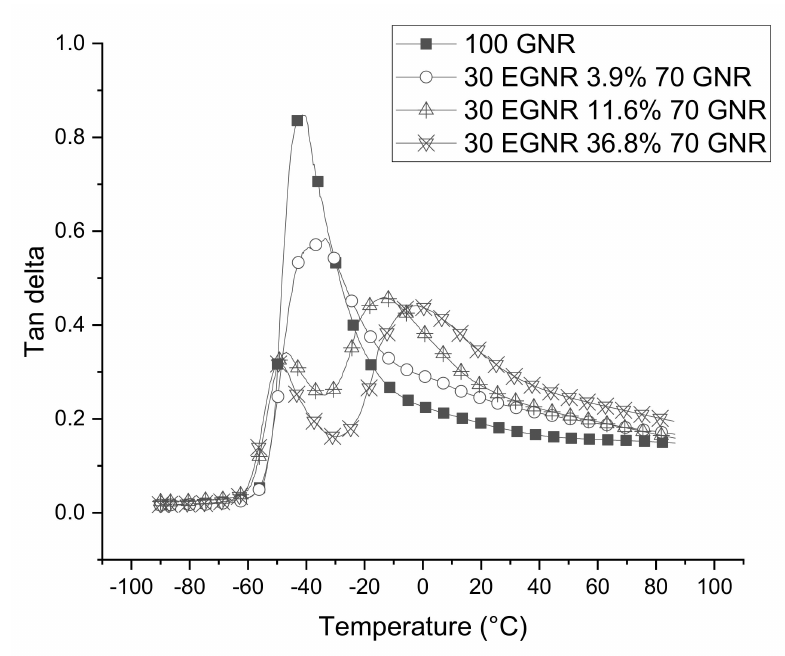
Figure 9. Tan δ of guayule natural rubber/epoxidized guayule natural rubber blend composites with various epoxide fractions. GNR 50CB: guayule natural rubber composites without epoxidation; 30EGNR 3.9% 70GNR 50CB: guayule natural rubber/epoxidized guayule natural rubber blend com- posites with 3.9% epoxide fraction; 30EGNR 11.6% 70GNR 50CB: guayule natural rubber/epoxidized guayule natural rubber blend composites with 11.6% epoxide fraction; 30EGNR 36.8% 70GNR 50CB: guayule natural rubber/epoxidized guayule natural rubber blend composites with 36.8% epoxide fraction. Table 6. Estimated wet traction and rolling resistance of guayule natural rubber (GNR) and GNR/epoxidized guayule natural rubber (EGNR) blend composites. Epoxide Fraction